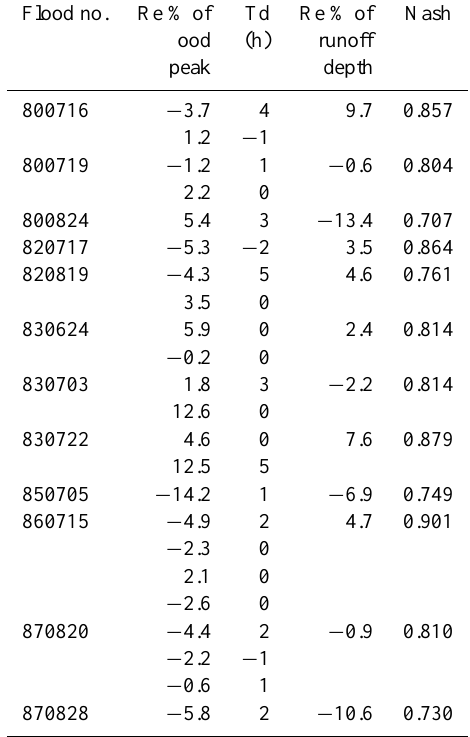
Table 2. Results of daily runoff simulation using the REW ap- proach.